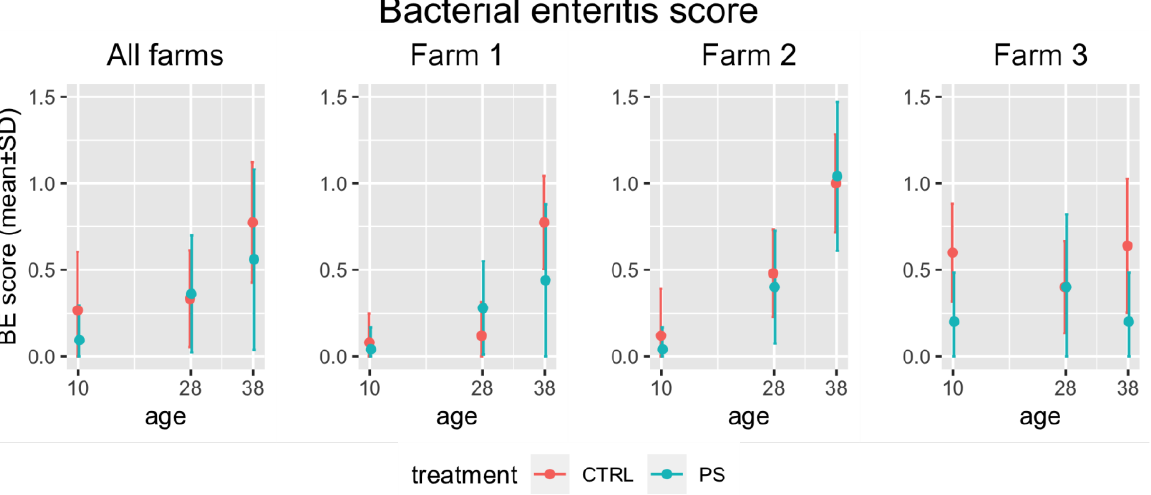
Figure 1. BE score measured in treatment (PS) and control (CTRL) groups at different time points by considering all farms together and then each one separately. BE scores are expressed on a scale from 0 (normal gastrointestinal tract) to 4 (severe dysbacteriosis). Table 1. Mean ± standard deviation of the histopathological lesion scores measured at duodenum, jejunum, ileum and caecum level of treated (PS) and control (CTRL) birds. Scores are reported on a scale from 0 (absent or rare leukocytic infiltration) to 3 (leukocytic infiltration in the range of 50% of a × 400 field). p -values below 0.05, marking the statistical significance of a difference observed when comparing treatment and control groups across all farms or in each farm individually, are